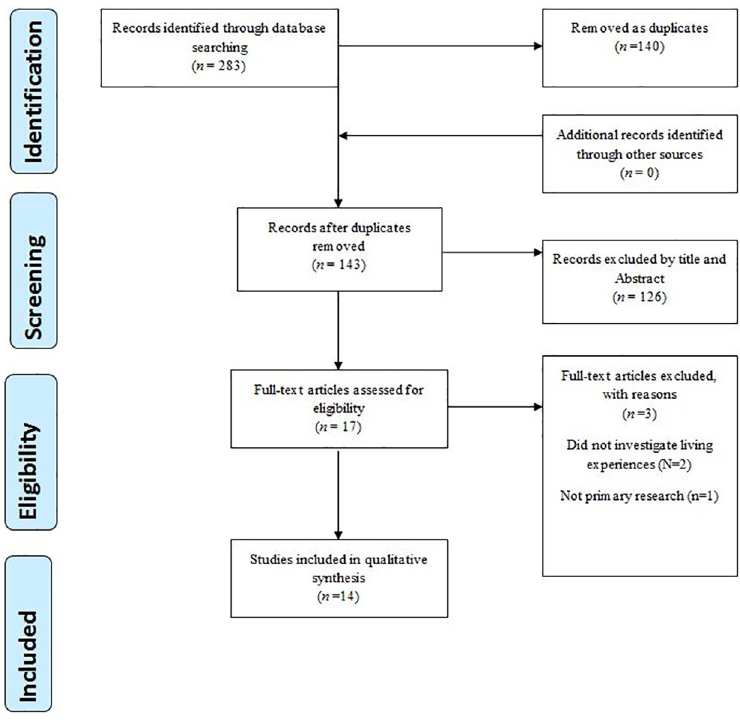
Fig 1. PRISMA flow diagram for patients experiences of living with peripheral arterial